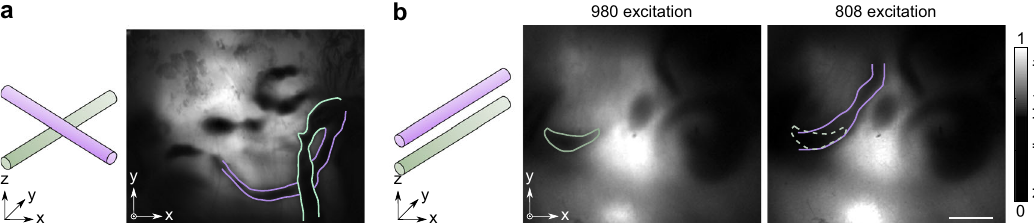
Fig. 7 TIP resolved overlapped intestinal segments. a Left: the schematic shows the intersection of two sections of the intestine; right: TIP image clearly showed the intersection of two intestines. b Left: the schematic shows the fully overlap of two sections of the intestine; middle and right: dual-contrast TIP imaging differentiated two overlaid intestines. Scale bar: 5